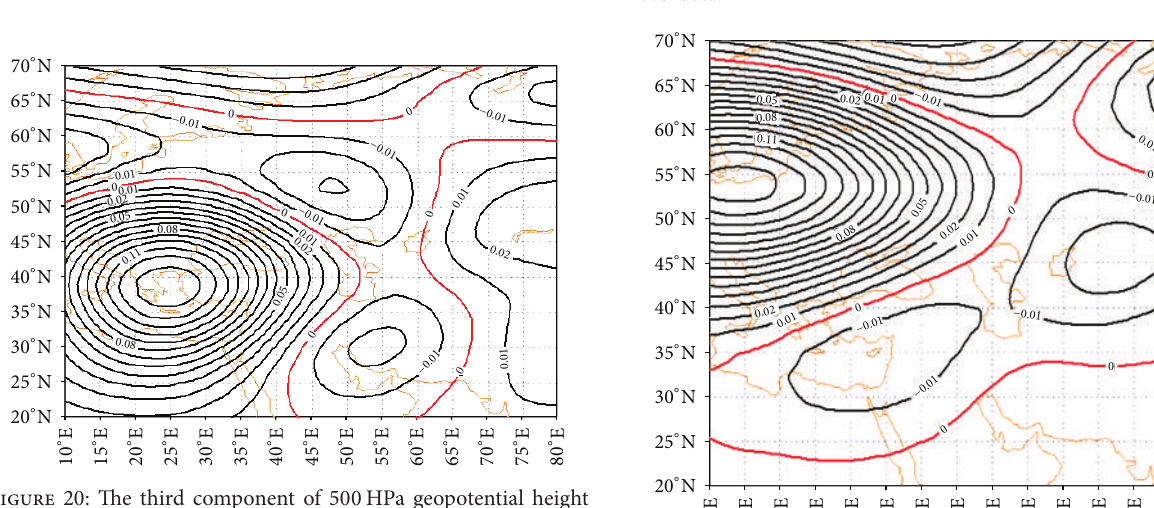
Figure 21: The fourth component of 500HPa geopotential height level data.